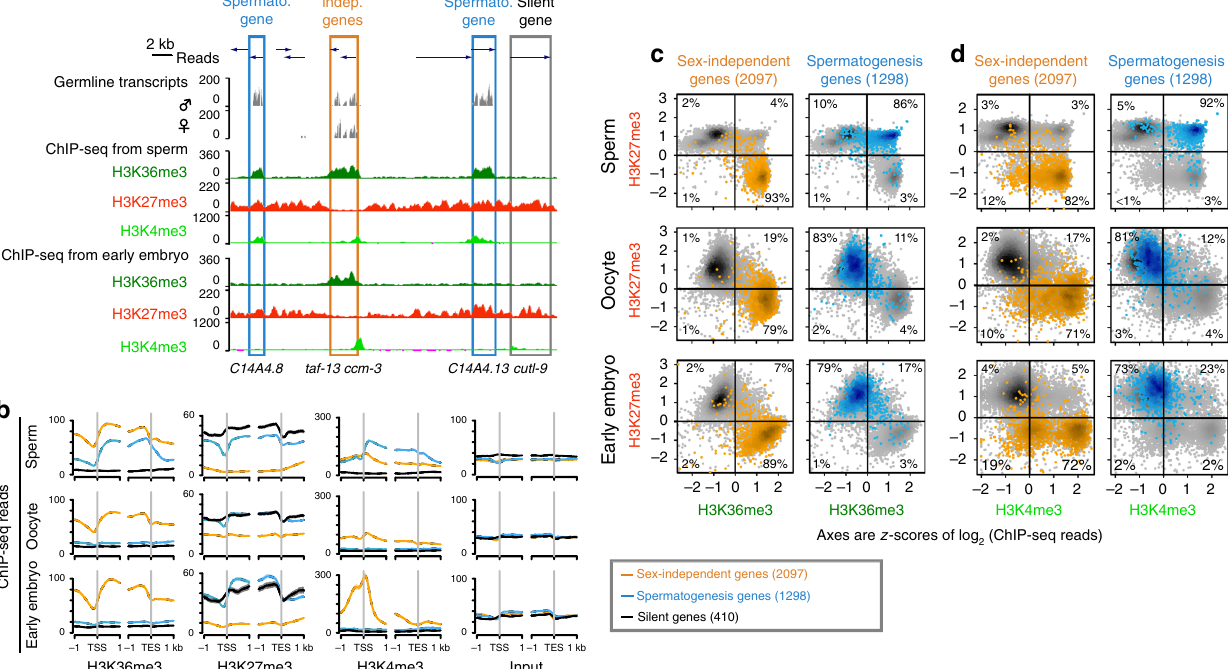
Fig. 2 Spermatogenesis genes are marked with both active and repressive histone modi fi cations in sperm. a Genome-browser views of RNA-seq data from spermatogenic and oogenic germlines, and ChIP-seq data (H3K36me3, H3K27me3, and H3K4me3) from sperm and early embryos. Blue: genes transcribed exclusively in spermatogenic germlines ( “ spermatogenesis genes ” , Methods). Gold: genes transcribed in both spermatogenic and oogenic germlines ( “ sex- independent genes ” , Methods). Open-box: gene not transcribed in spermatogenic or oogenic germlines. The y-axis shows normalized ChIP-seq read counts. b Normalized ChIP signals around (1 kb up- and downstream) the transcript start site (TSS) and transcript end site (TES) over sex-independent, spermatogenesis, and silent genes in sperm, oocytes, and early embryos. c , d Scatter plots of mean normalized gene-body H3K36me3 ( c ) or promoter H3K4me3 ( d ) vs. gene-body H3K27me3 ChIP signals for all coding genes (gray), highlighting sex-independent genes (gold) and spermatogenesis genes (blue) and noting the % of genes in each quadrant. Classes of genes are shown in separate panels in Supplementary Fig. 5